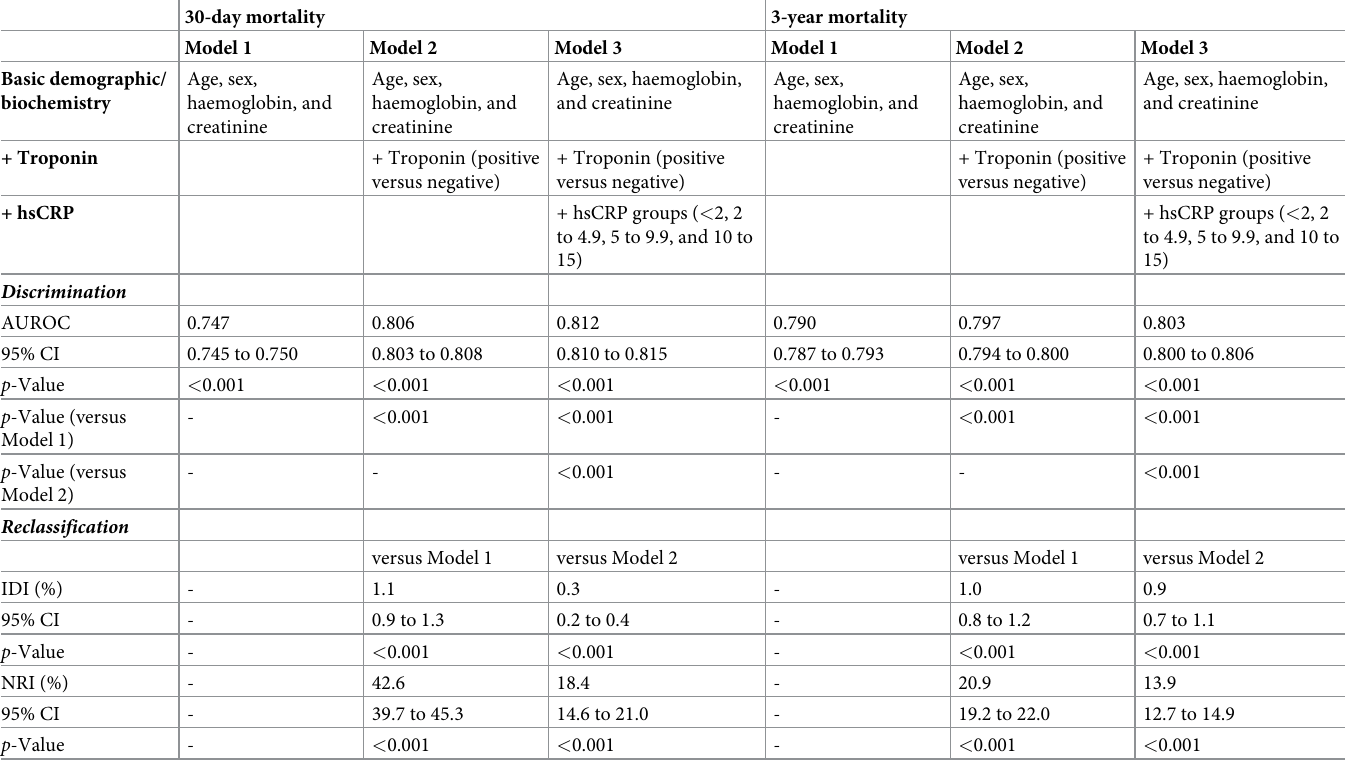
Table 2. hsCRP risk model discrimination, calibration, and